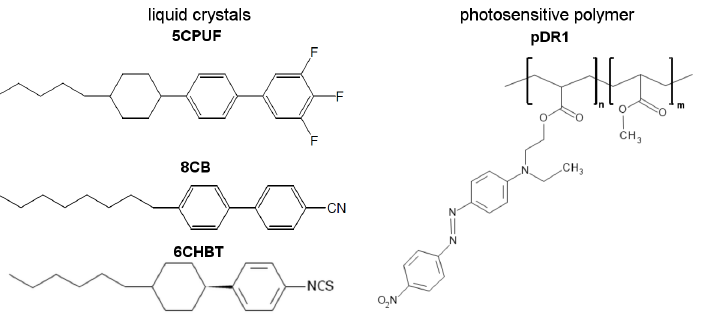
Figure 1. Molecular structure of liquid crystals 5CPUF, 8CB, 6CHBT and of the photosensitive polymer